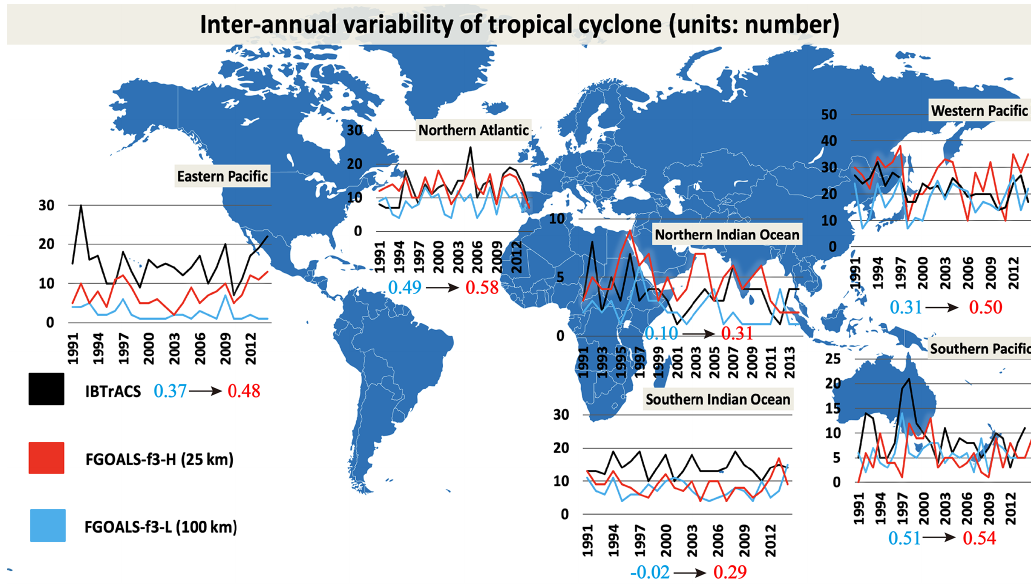
Figure 7. Interannual variability of tropical cyclones in the western Pacific, southern Pacific, northern Indian, northern Atlantic, eastern Pacific and southern Indian oceans (units: number of cyclones) during the time period 1991–2014. The numbers under the line charts are the correlation coefficients between IBTrACS and